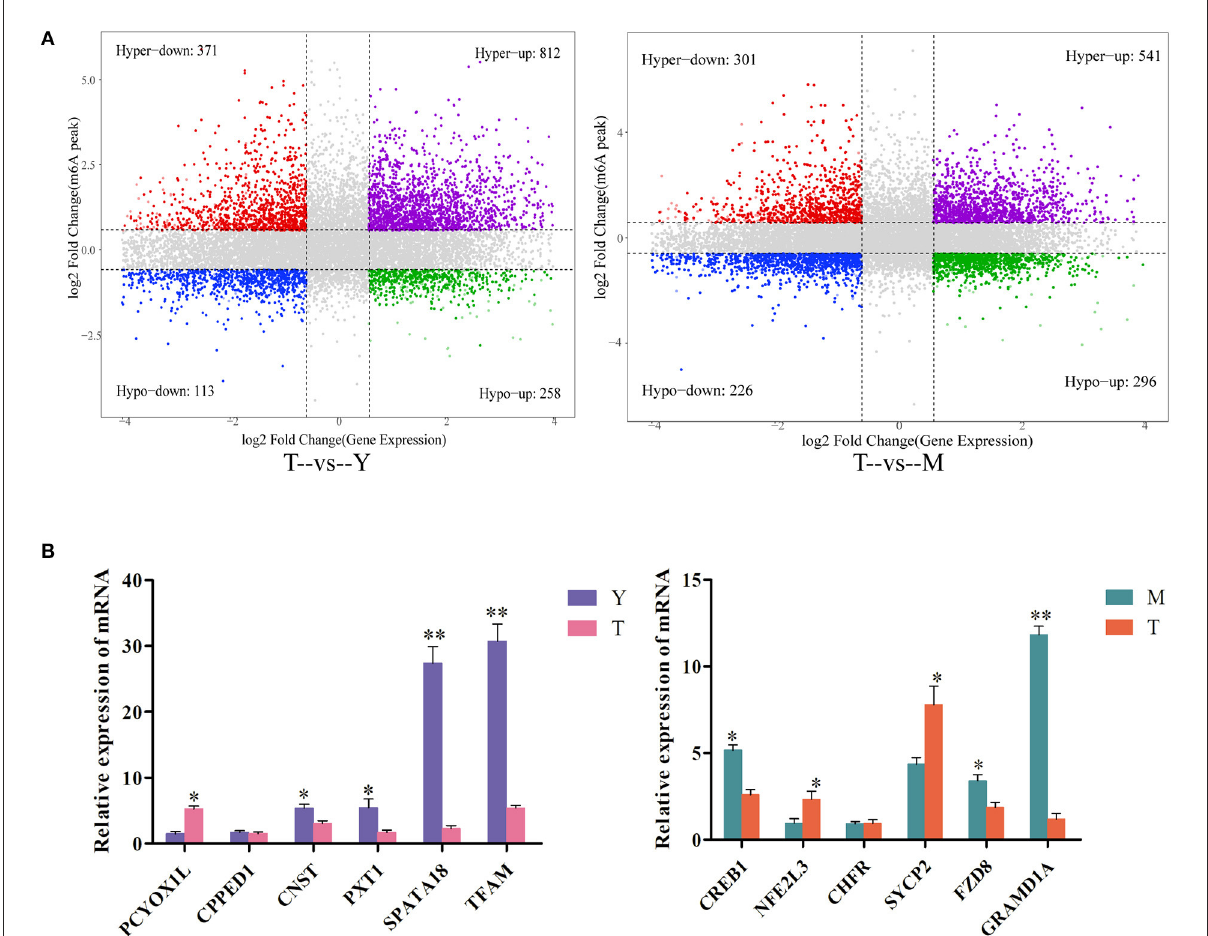
FIGURE7 Combined analyses of differentially expressed and differentially methylated genes. (A) A combined four-quadrant scatterplot highlighting genes exhibiting significantly altered methylation and expression patterns when comparing the indicated samples, with gray dots corresponding to genes that did not exhibit any significant differences. (B) qPCR-based validation of DEGs identified via RNA-seq analyses. ** P < 0.01, * P < 0.05